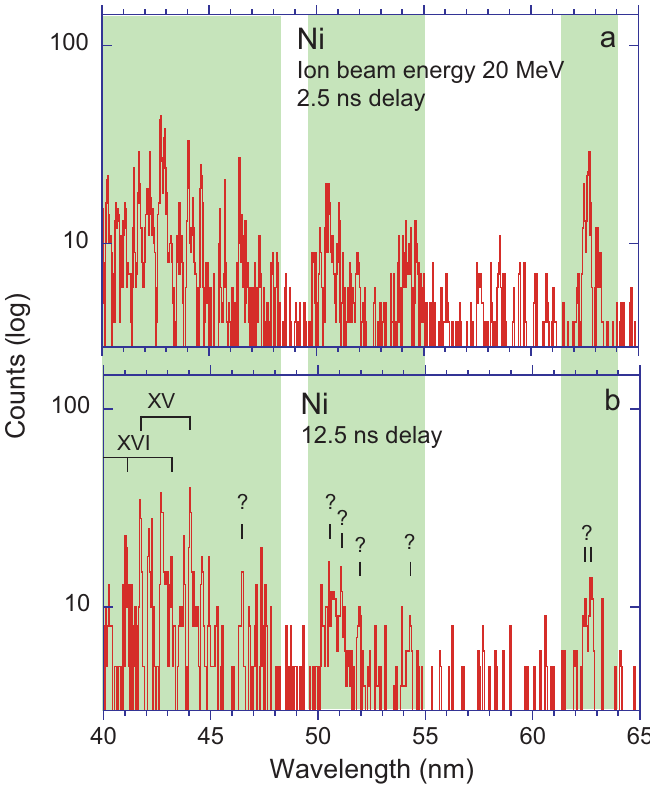
Figure 21. Beam–foil spectra of Ni at an ion beam energy of 20 MeV. ( a ) Observation at a delay of about 2.5 ns after excitation, line width (FWHM) 0.09 nm; ( b ) observation at a delay of about 12.5 ns after excitation, line width (FWHM) 0.11 nm. The strongest lines are identified by the spectrum number. Unidentified lines are marked by a fiducial with a question mark. The charge state distribution is centered on q = 13 + , and ion charge states q = 10 + to q = 17 + are expected to contribute. The green bands mark ranges of evident emission by long-lived levels. ( a ) and ( b ) continue the spectra of Figure